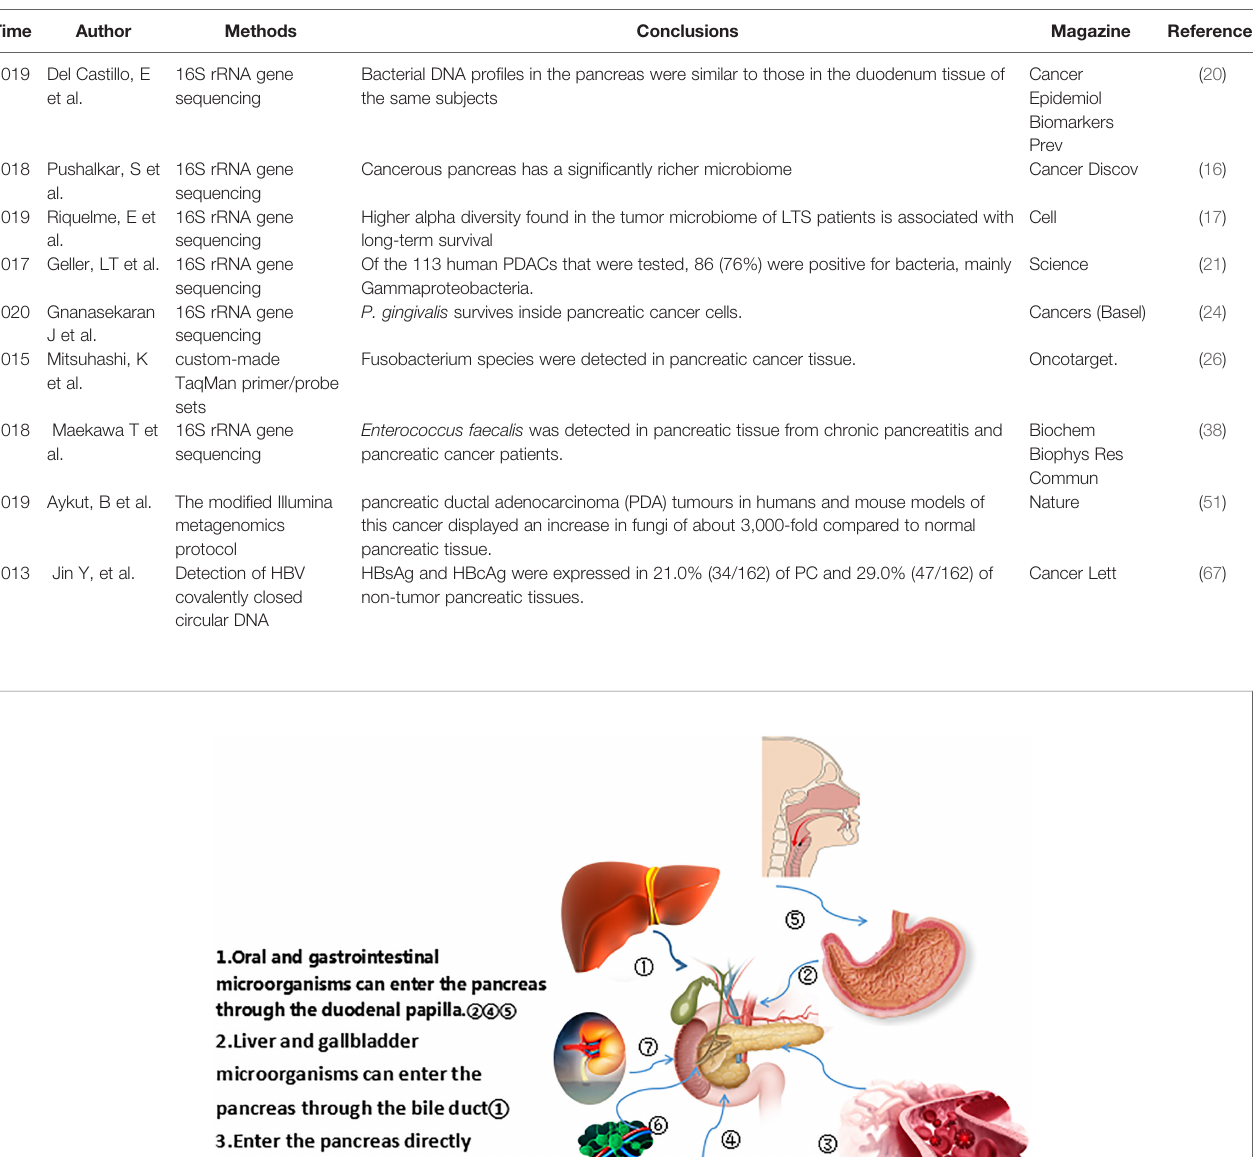
TABLE 1 | Research on microorganism and pancreatic cancer in pancreas and pancreatic